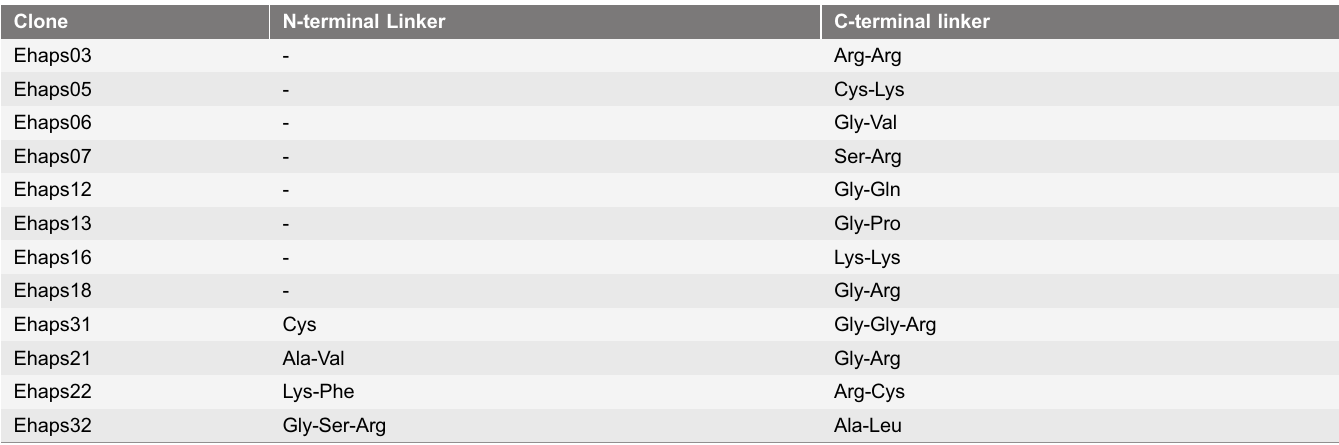
Table 1. List of linker library members with switching abilities similar to